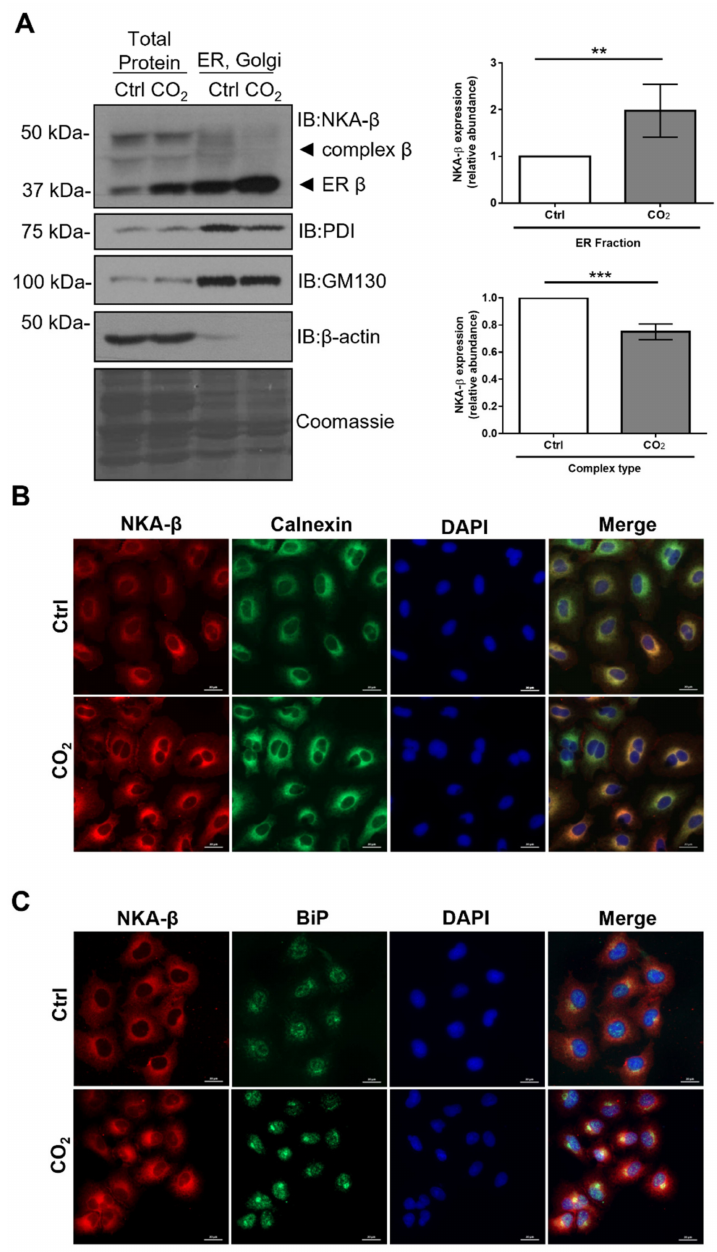
Figure 3. Elevated CO 2 levels promote endoplasmic reticulum (ER) retention of Na,K-ATPase- β . ( A ) A549 cells were exposed to 40 (Ctrl) or 120 mmHg CO 2 (CO 2 ) with an extracellular pH = 7.4 for 12 h. Subcellular fractions were isolated by ultracentrifugation and protein levels of the NKA- β , protein disulfide isomerase (PDI; an ER marker), and Golgin subfamily A member 2 (GM130;a Golgi marker) were analyzed by immunoblotting. Representative Western blots are shown. Bars represent ER NKA- β / Coomassie ratio or complex type NKA- β / Coomassie ratio. Values are expressed as mean ± SD ( n = 4, ** p < 0.01, *** p < 0.001). ( B ) A549 cells were exposed to 40 (Ctrl) or 120 mmHg CO 2 (CO 2 ) with an extracellular pH = 7.4 for 12 h. Cellular localization of NKA- β and calnexin were determined by immunofluorescence. Immunofluorescence staining of NKA- β (red), calnexin (green), and nuclei (blue) are shown. Scale bar—20 µ M. ( C ) A549 cells were exposed to 40 (Ctrl) or 120 mmHg CO 2 (CO 2 ) with an extracellular pH = 7.4 for 12 h. Cellular localization of NKA- β and BiP were determined by immunofluorescence. Representative immunofluorescence staining of NKA- β (red), BiP (green), and nuclei (blue) are shown. Scale bar—20 µ